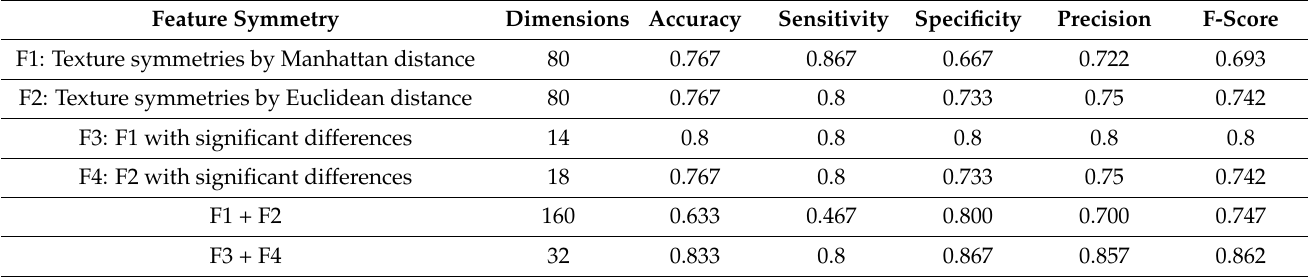
Table 9. Diagnostic performance of facial paralysis using different texture feature symmetry combinations. Feature